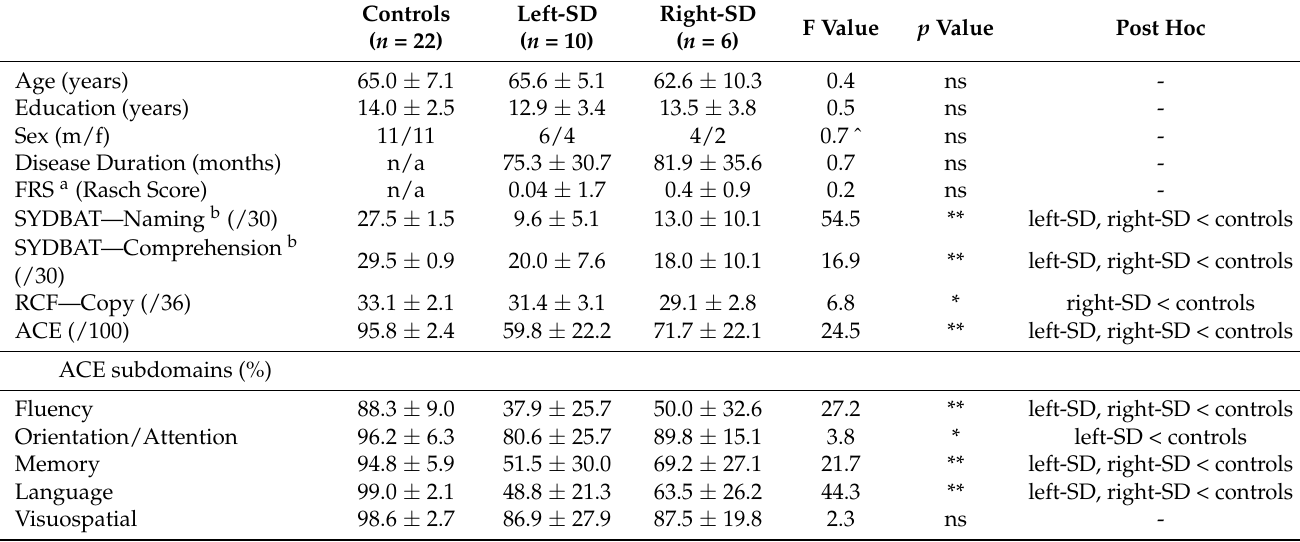
Table 1. Demographic information and neuropsychological performance in semantic dementia patients and